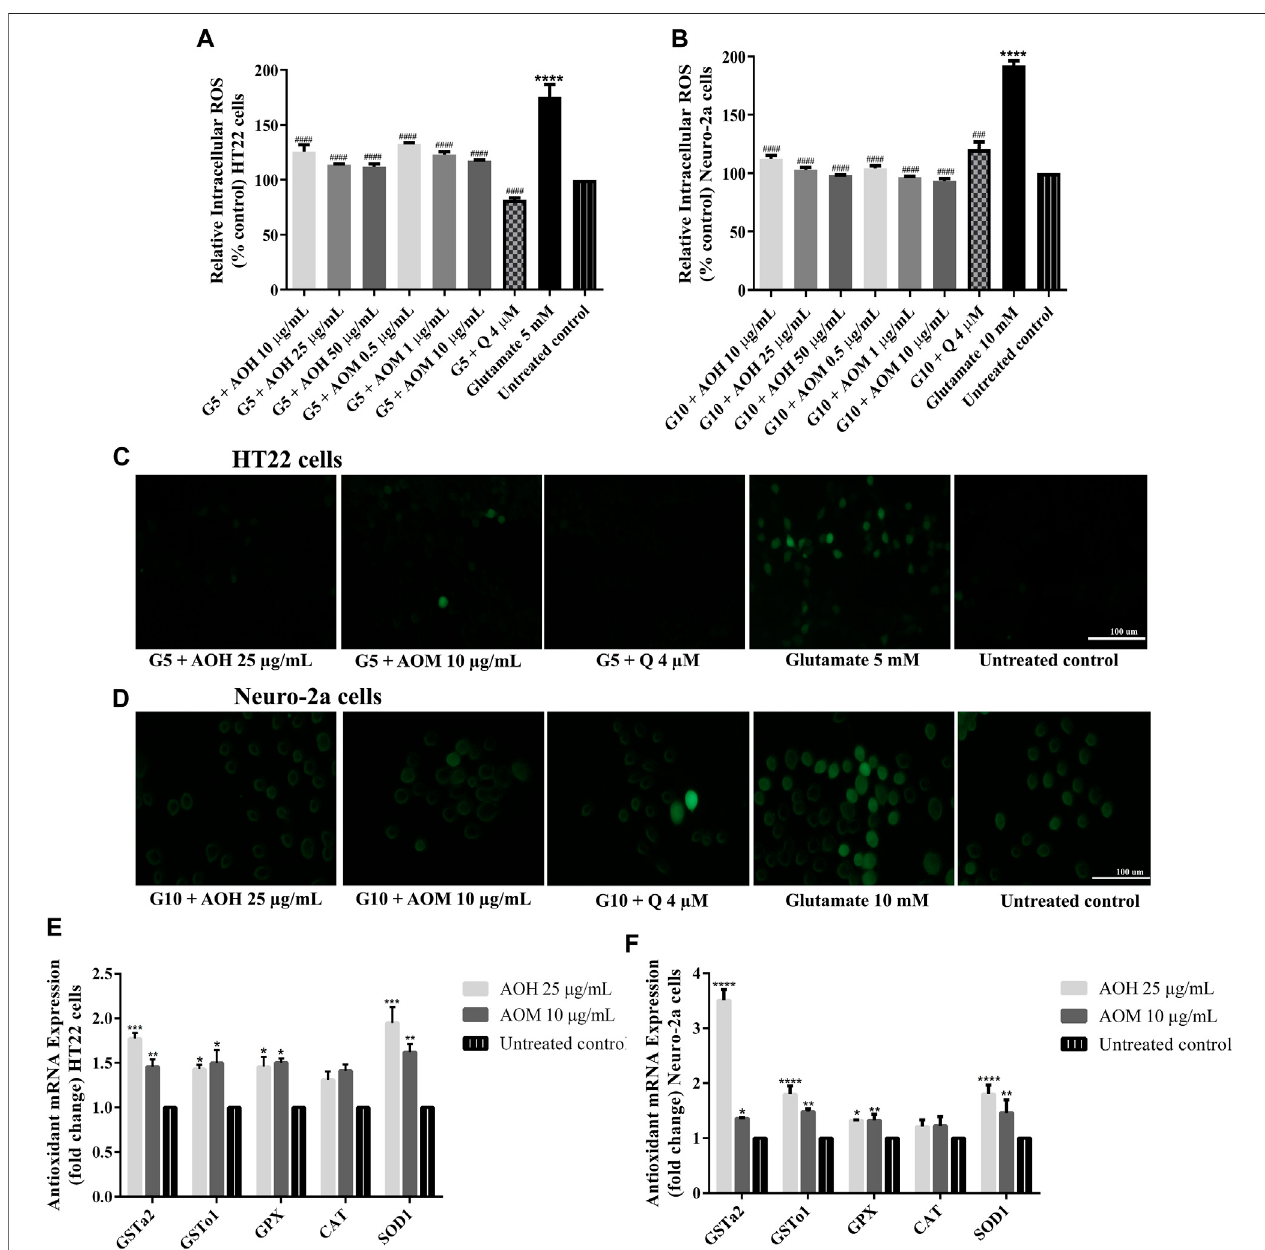
FIGURE 5 | Protective effect of AO extracts on glutamate-induced oxidative stress. AO extract treatment reduced ROS levels in HT22 (A) and Neuro-2a (B) cells whencomparedtoglutamate-treatedcells.Representative fl uorescencemicrographsofHT22 (C) andNeuro-2a (D) cellsstainedwithDCFH-DAwereobservedundera fl uorescence microscope(10 × )(Representativemicroscopy images fromDCFH-DA, phasecontrastand nuclearstainingcanbefoundinthe SupplementaryMaterial Figure S5 . Samples were treated with AO extracts for 48 h and exposed toglutamate (G5: 5 mM glutamate, G10: 10 mM glutamate) for 12 h (HT22 cells) or 18 h (Neuro-2acells)toinduceoxidativestress.AOextracttreatmentincreasedendogenousantioxidantgeneexpressioninHT22 (E) andNeuro-2a (F) cellswhencompared tountreated control. β -actin wasused astheinternalcontrolforRT-PCRassay.Theresultsareexpressed asthemeans ± SEMofindependentexperiments( n (cid:1) 3). * p < 0.05,** p < 0.01,*** p < 0.001and**** p < 0.0001,compared totheuntreated control;# p < 0.05,## p < 0.01,### p < 0.001and#### p < 0.0001,comparedtothegroup exposed to glutamate only.